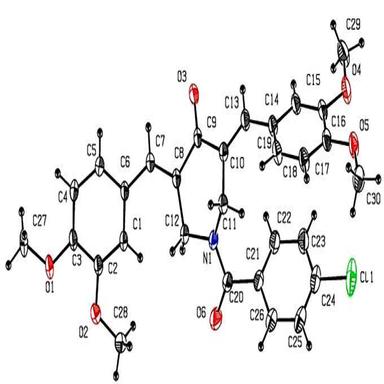
ORTEP PLOT WITH NUMBERING SCHEME DRAWN AT 30% PROBA-BILITY LEVEL OF THE COMPOUND